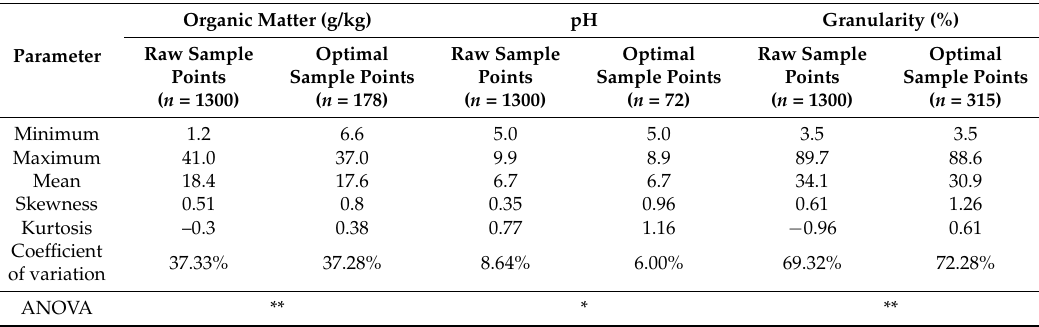
Table 2. Descriptive statistics of soil properties based on raw data and on sample points that were optimized with the improved simulated annealing (SA)